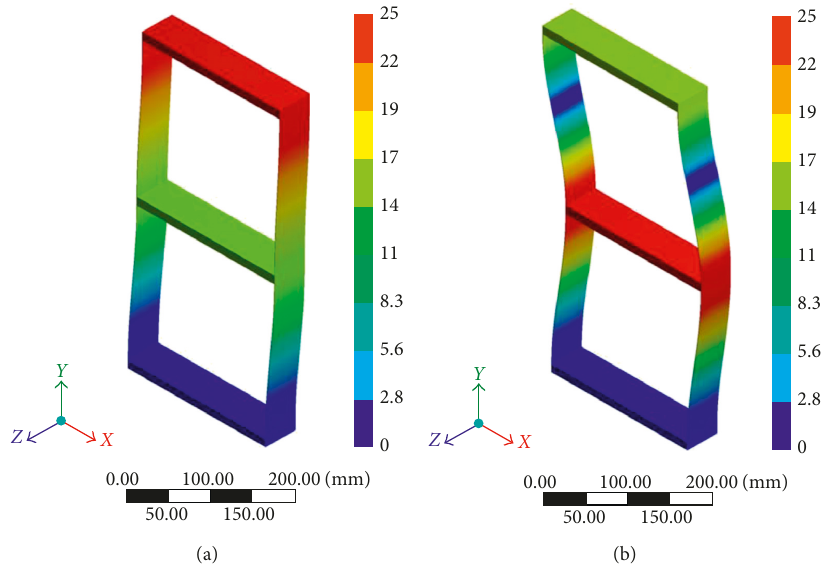
Figure 12: Modal shape obtained by numerical simulation. (a) First mode and (b) second